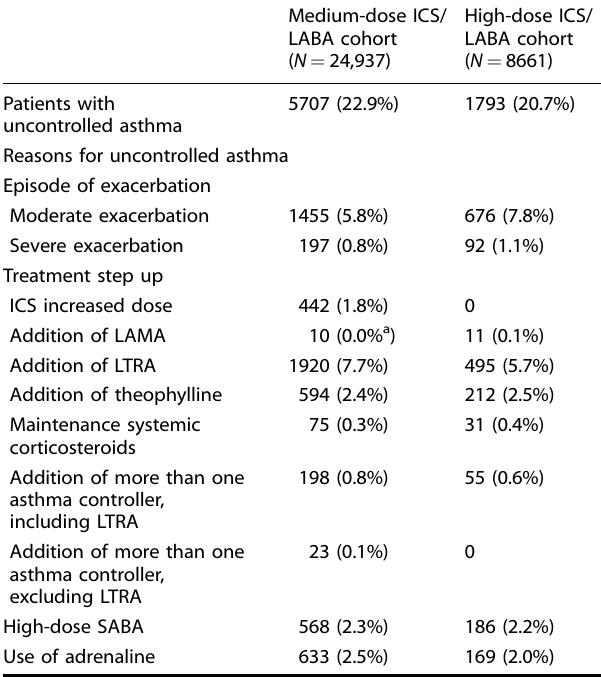
Table 1. Asthma control in medium- and high-dose ICS/LABA cohort and reasons for uncontrolled asthma